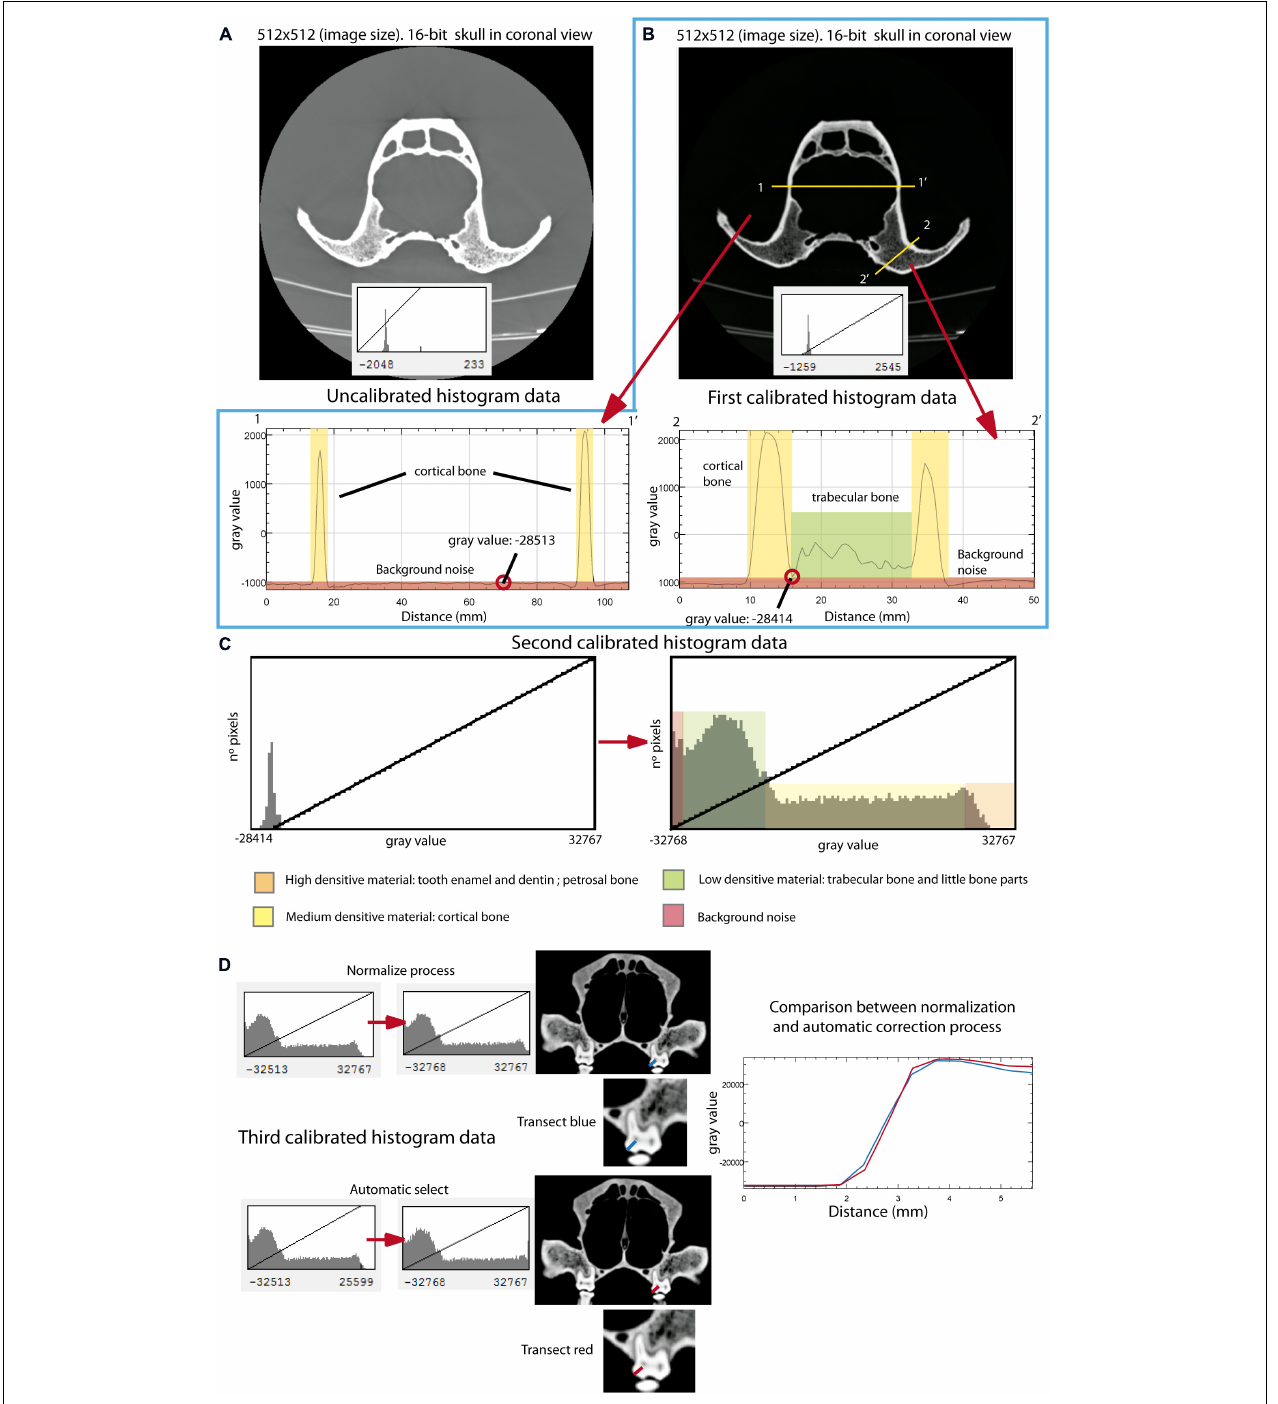
FIGURE 2 | Image cleaning and calibration process using the skull of Ursus americanus (VU261) as an example. (A) Original image stack obtained from the XCT scanning (upper) with no-calibrated histogram (lower) in coronal view. (B) First step for calibrating the histogram. Note that two different transects across the object are represented by a yellow line. The respective two plot profiles from these two transects are represented in this figure: the cortical bone represented in yellow areas and the trabecular bone represented in green areas. Note that in the first transect there is no trabecular bone. The red color in both plot profiles represents the background noise. (C) Histogram resulted from the process of calibration and cleaning obtained in the first step. The left graph is the original histogram of one image only, and the right graph is the resulting histogram after cropping the gray values in the left diagram corresponding to the background noise. (D) After repeating the same process as in (B,C) , the third step for histogram calibration is using the process of normalization (upper graphs) and the automatic selection method (bottom graphs). On the right side, there is a plot comparing both methods, plotting gray values on a transect when using normalization (blue line), and the automated selection method (red